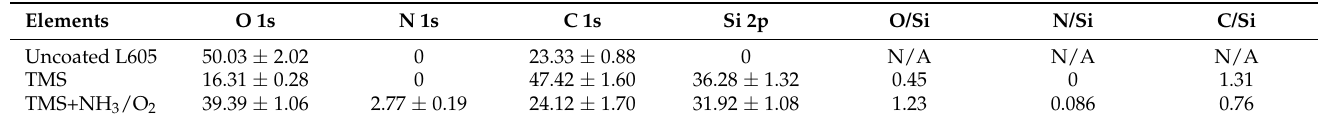
Table 2. XPS surface atomic percentages (at.%) of uncoated L605 and plasma-nanocoated coupons, n =